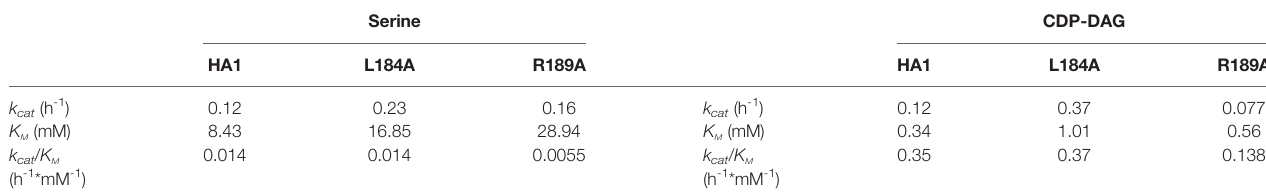
TABLE 5 | The k cat , K M and k cat/ K M of HA1, L184A and R189A for both serine and CDP-DAG.